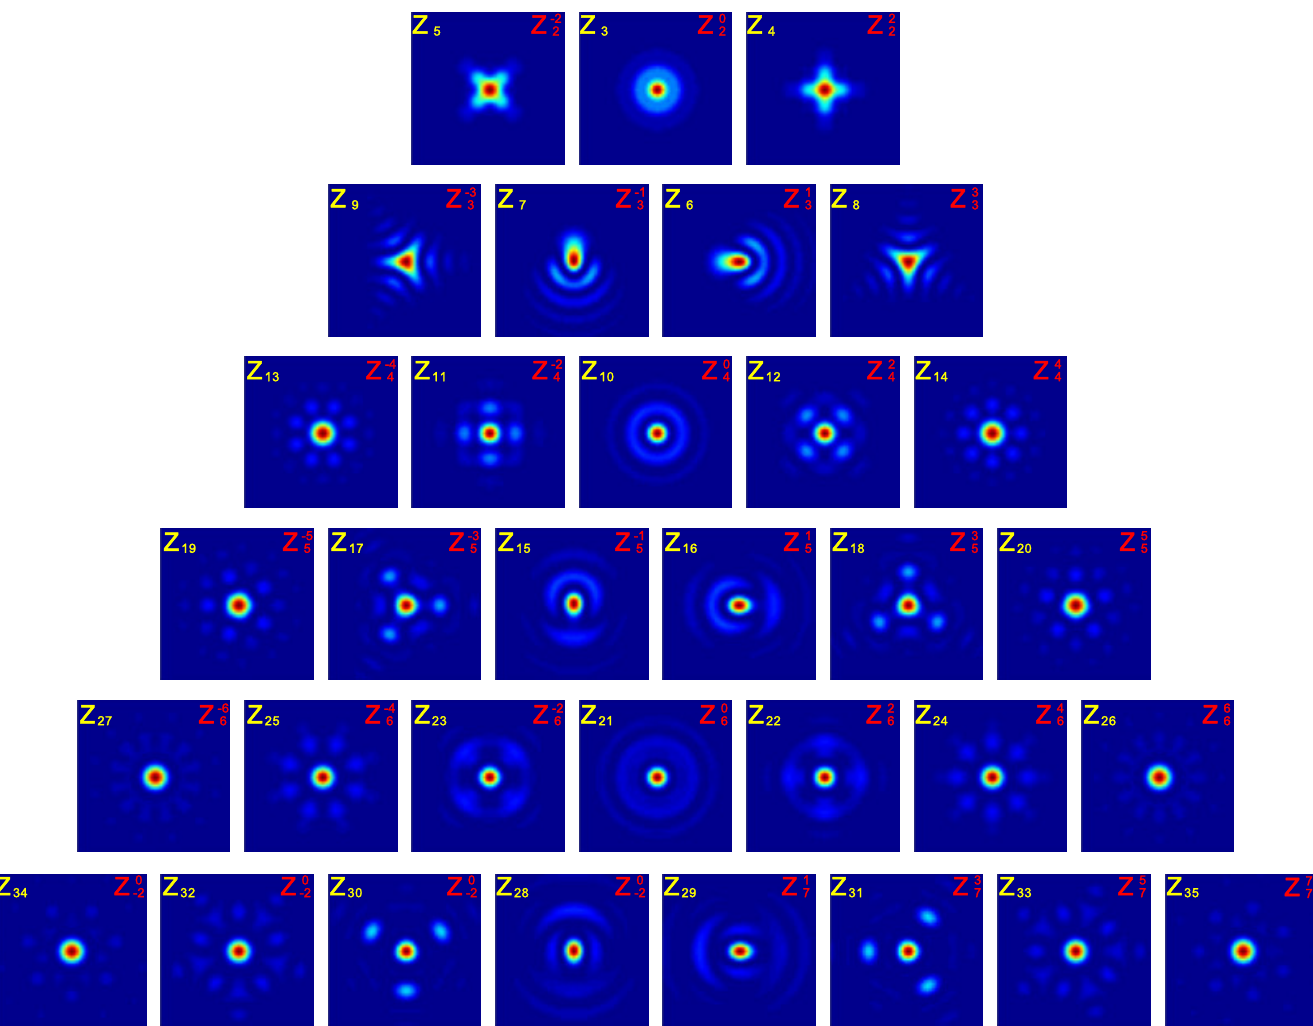
Figure 8. The far ‐ field focal plane intensity pattern of single ‐ order aberration orders 3–35.